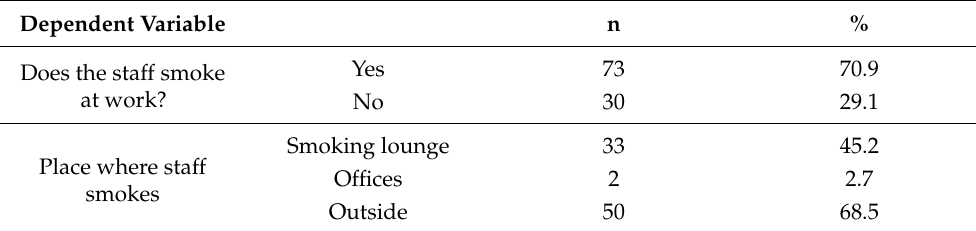
Table 3. Patients’ accounts on staff’s smoking habits in the